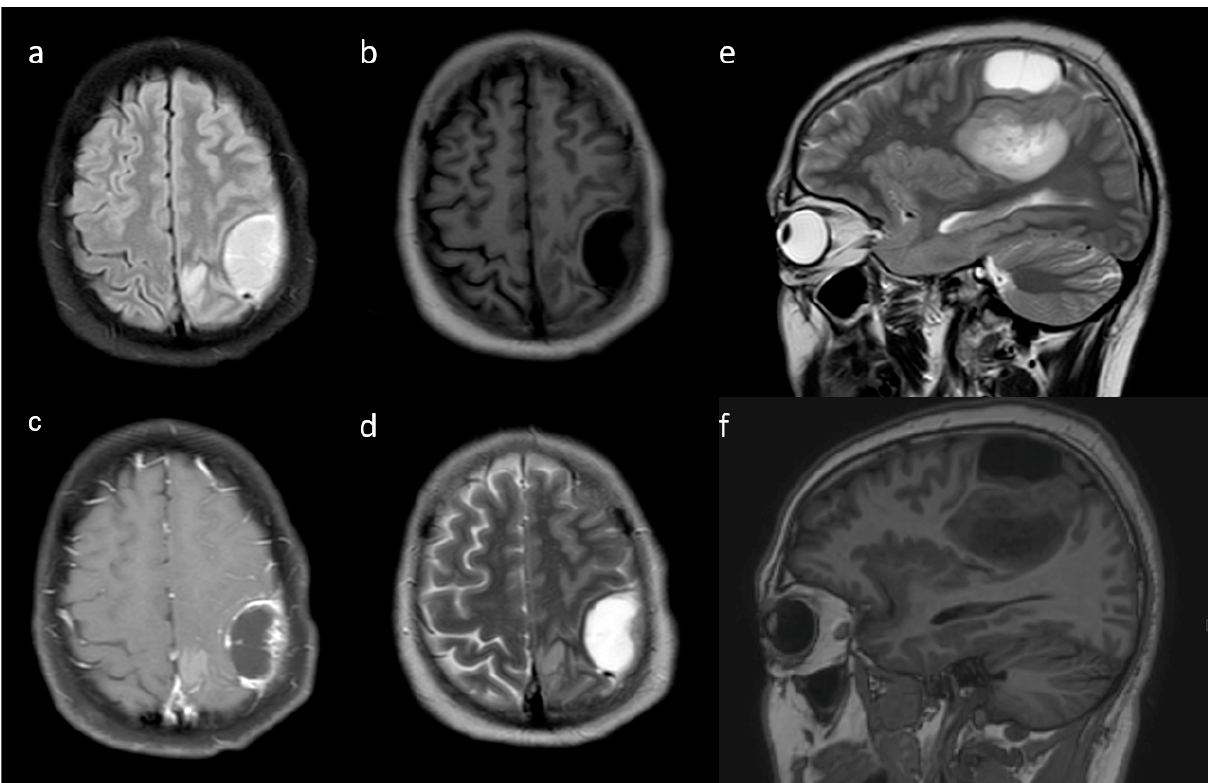
Figure 3. ( a – d ) Representative FLAIR images showing various proportions of edema: ( a ) none, ( b ) less than tumor volume, ( c ) equal to tumor volume, and ( d ) more than tumor volume.